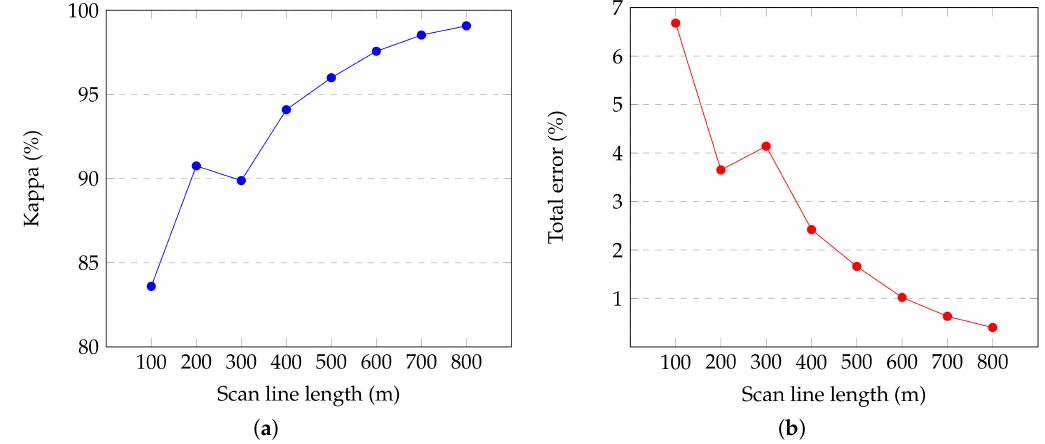
Figure 19. Kappa ( a ) and total error ( b ) in the synthetic Heidelberg’s site for different scan-line lengths.